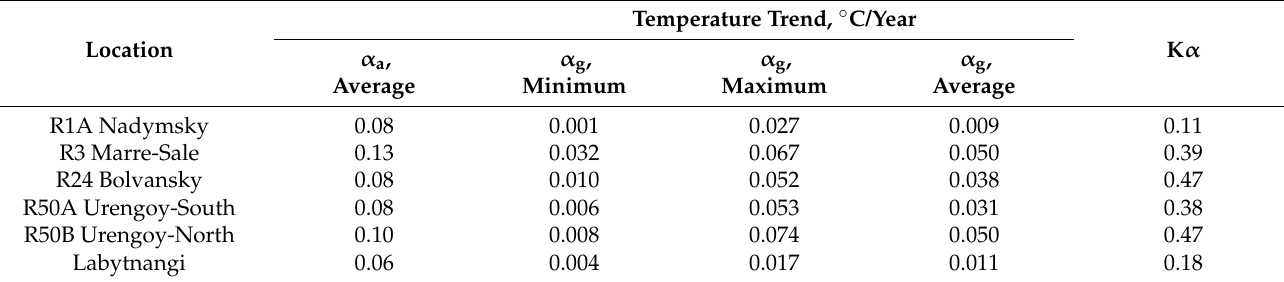
Table 4. Linear trends of changes in the mean annual air temperature and the permafrost for 1990–2020 according to all temperature